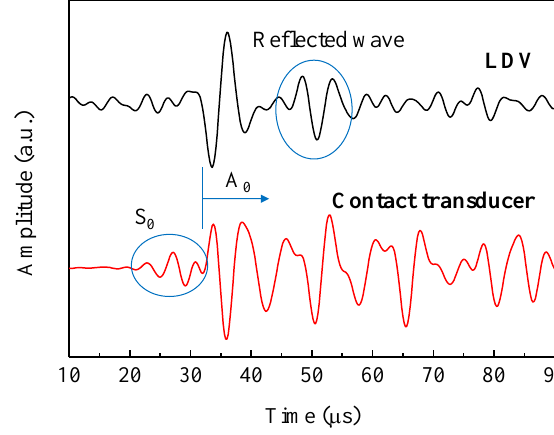
Figure 7. Lamb wave propagation in the impacted carbon fiber reinforced polymer (CFRP) quasi- isotropic laminate using a contact resonant ultrasonic transducer. ( a ) 30 μs; ( b ) 40 μs; ( c ) 50 μs; ( d ) 60 μs.